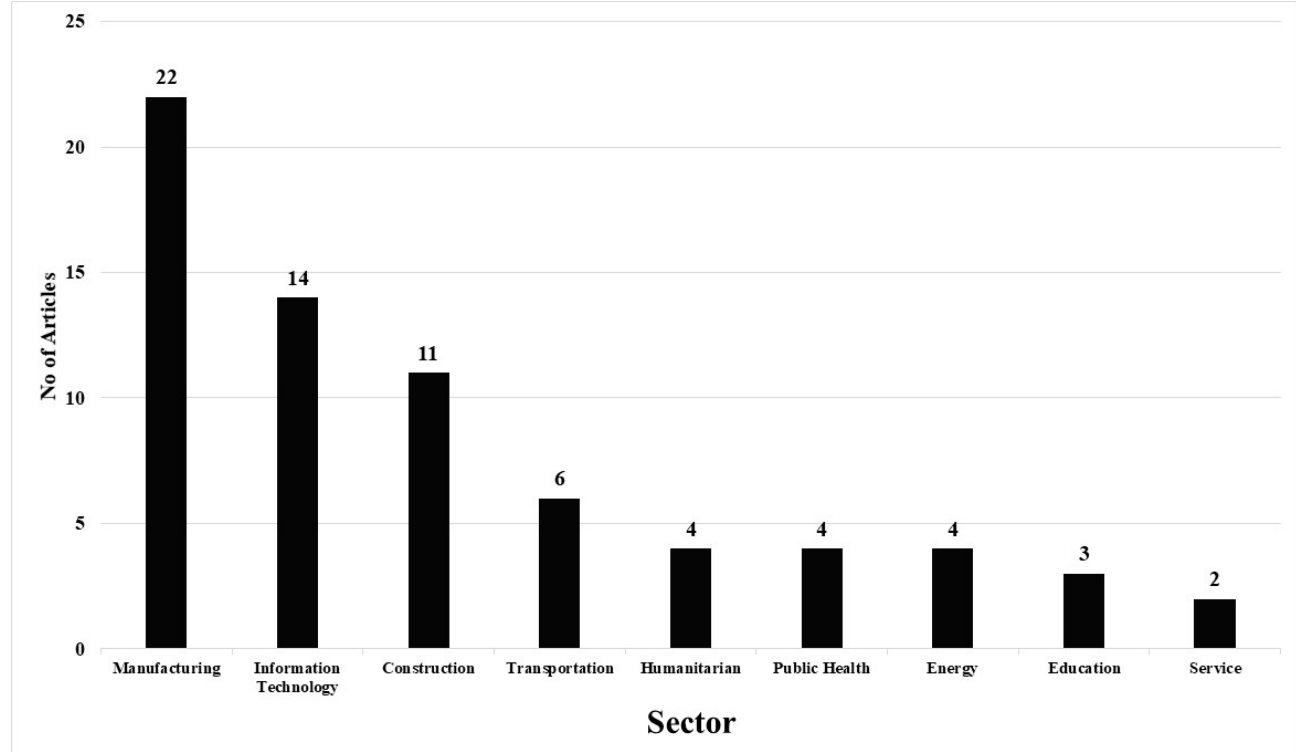
Figure 5. Number of articles by sector.